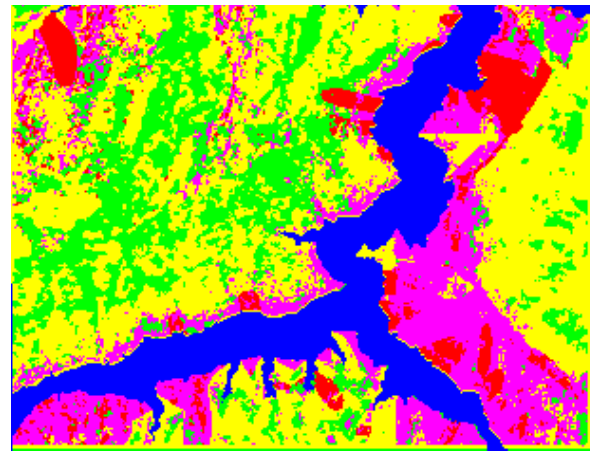
Figure 20. Forecast result of Mahalanobis Distance.